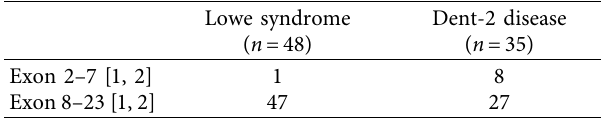
Table 5: Different mutation locations from Lowe syndrome and Dent-2